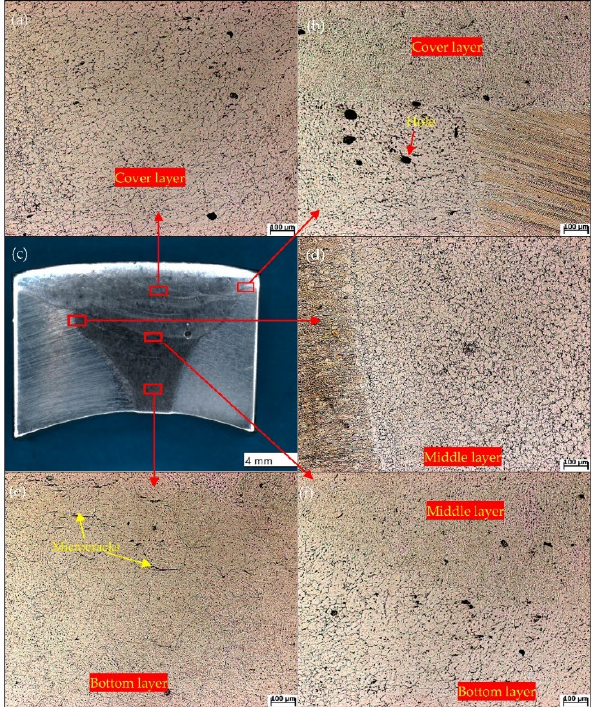
Figure 11. Face bending specimen metallography of the ER5087 welded joint, ( a ) the weld center of the cover layer, ( b ) the interface between the cover and middle layers, ( c ) the macromorphology of cross-section of the weld joint, ( d ) the FZ of the middle layer, ( e ) the weld center of the bottom layer, and ( f ) the interface between the middle bottom layers .